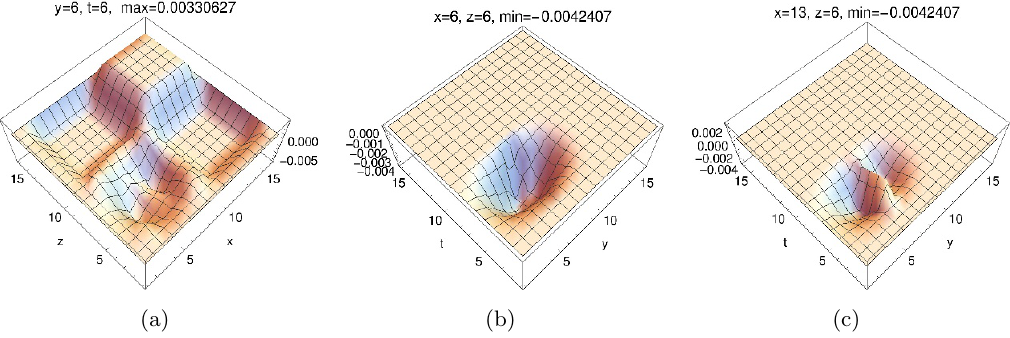
Figure 4 . The topological charge density in two characteristic planes for two intersecting anti- parallel xy- and zt-vortex pairs with ( z 1 = 6 ; z 2 = 13) and ( x 1 = 6 ; x 2 = 13) at t ? = y ? = 6 with thickness d = 3 and (cid:1) t = R = 4 on a 16 4 -lattice is displayed in the diagrams (a) and (b) for the situation of (cid:12)gure 3(a), where the center of the colorful region of the xy-vortex surrounds the intersection at lower x and lower z , x 0 = x 1 and z 0 = z 1 . Diagram (a) shows the topological charge density in the intersection plane y ? = t ? = 6 with the four intersection regions. The area around the intersection point x 1 = z 1 = 6 is in(cid:13)uenced by the surrounding color structure shown in the perpendicular yt-plane in diagram (b) as a broad, shallow depression. The intersection region at x 1 = z 1 = 6 forms a narrow, deep structure since the zt-vortex is de(cid:12)ned by y-links in one y-slice only. For the situation of (cid:12)gure 3(b) the two contributions at the intersection point x 0 = x 2 and z 0 = z 1 , a broad structure from the colorful region and a narrow one from the intersection, can be better distinguished in diagram (c), due the di(cid:11)erence in their signs. Diagram (c) displays the topological charge density in the yt-plane at the intersection point ( x 2 ; z 1 ) for the situation of (cid:12)gure 3(b), where now this other intersection is surrounded by the colorful